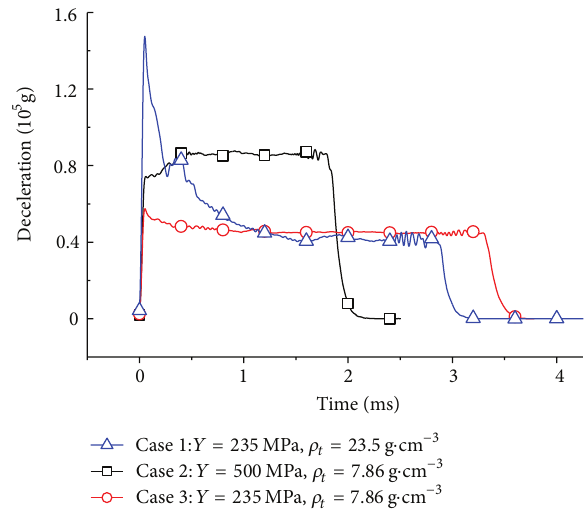
Figure 6: Deceleration versus time of projectile penetrating into steel target (all striking velocity = 1500m/s).